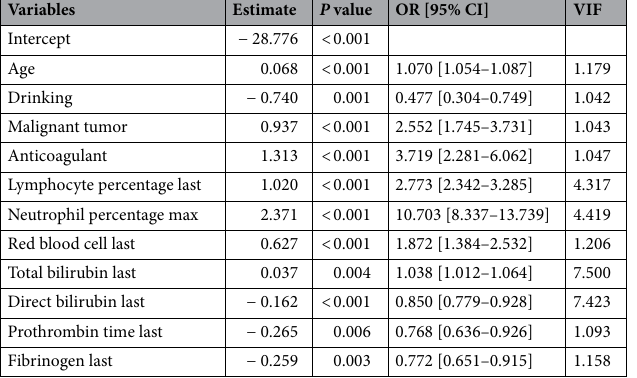
Table 2. Variables associated with PE. Last: The last test results before the diagnosis of pulmonary embolism. Max: The maximum test results before the diagnosis of pulmonary embolism.